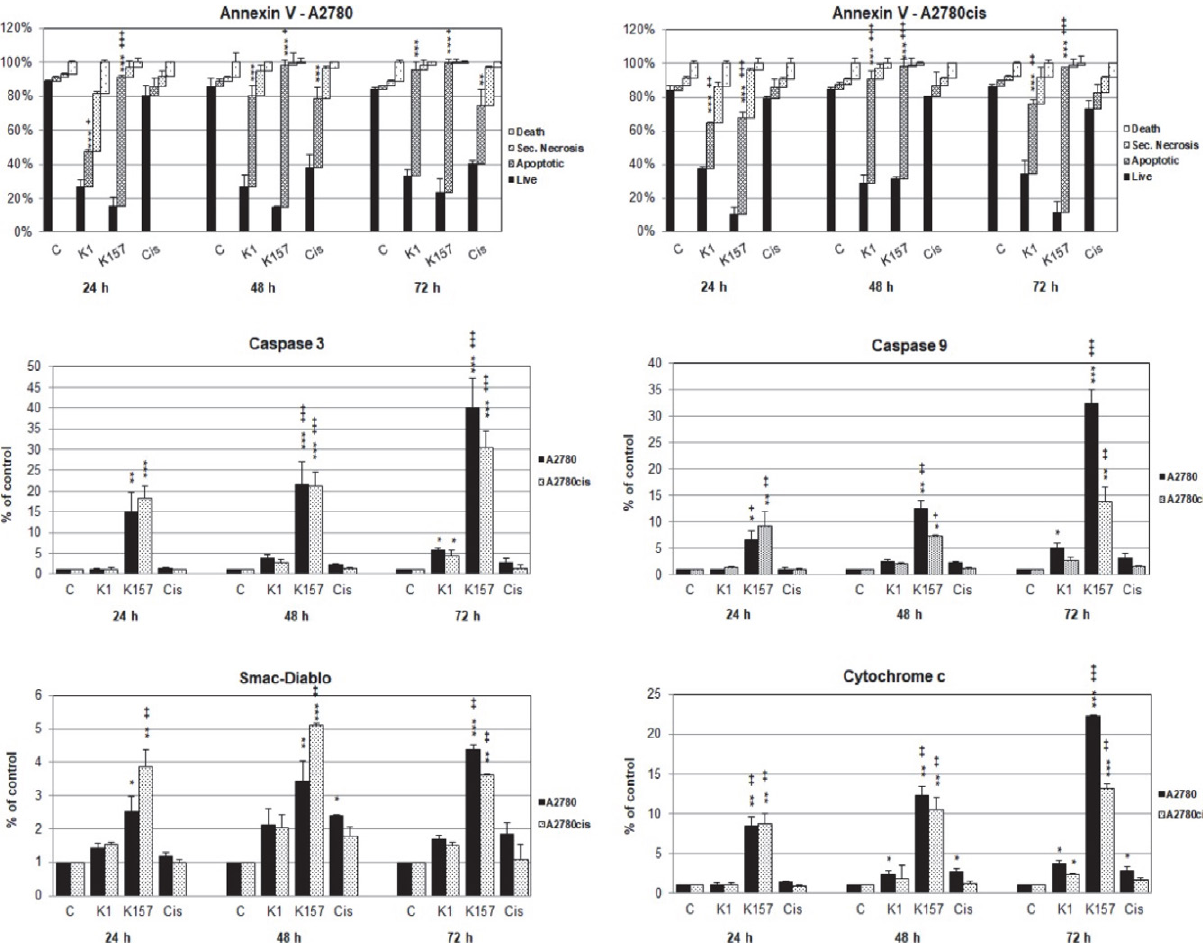
Figure 2. Effects of IC50 concentrations of homobrassinin (K1), thiazino[6,5-b]indol (K157), and cisplatin (Cis) on annexin V, caspase 3, caspase 9, smac-diablo, and cytochrome C in A2780 and A2780cis cell lines. The cells were grown in standard growth media for 24 h and then treated